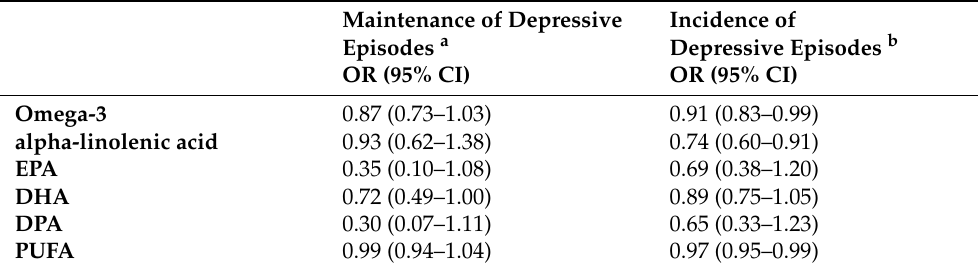
Table 4. Sensitivity analyses adjusted for changes in eating habits. ELSA-Brasil 2012 Study, 2014 (first follow-up